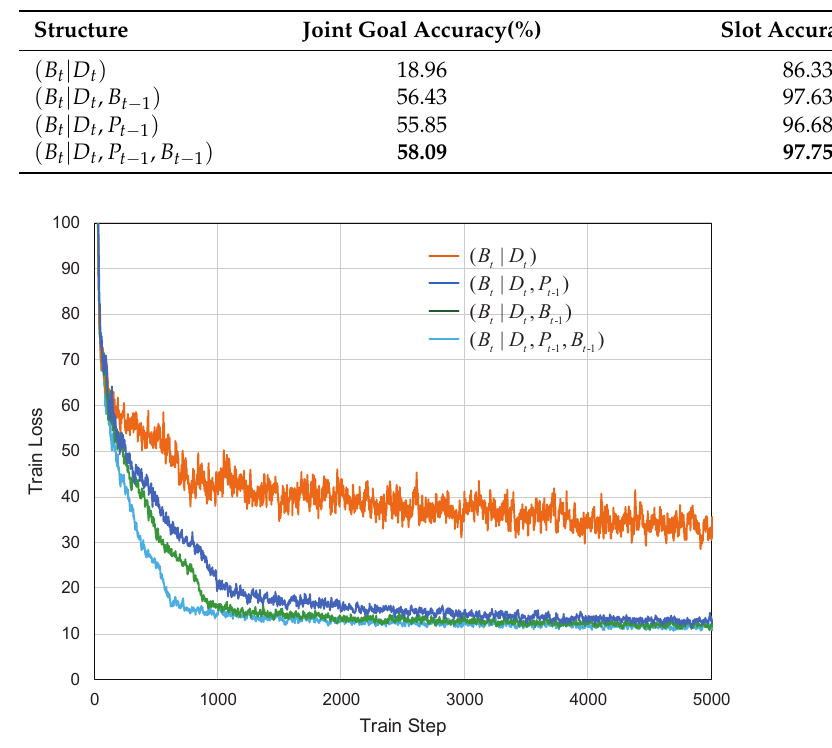
Figure 8. Train loss of different structures on the training set of MultiWOZ